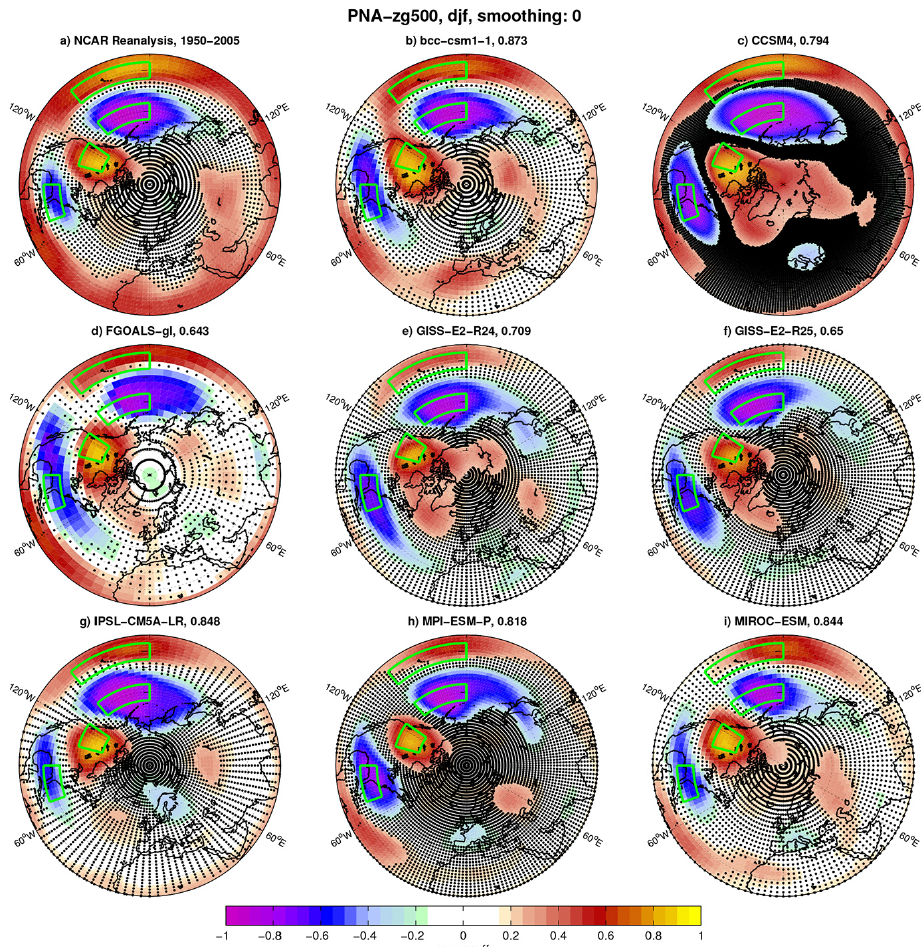
Figure 1. Observed and simulated correlation maps between the winter PNA index and winter Z 500 time series for the period 1950–2005. Dots mark grid points where the correlation is not significant at 95% confidence accounting for autocorrelation. The green boxes mark the areas used for the calculation of the PNA index. In panels (b–i) , the numbers reported in the respective titles are the spatial correlations between observed and simulated patterns calculated for the domain north of 20 ◦ N (to this end, NCAR data were regridded to the model